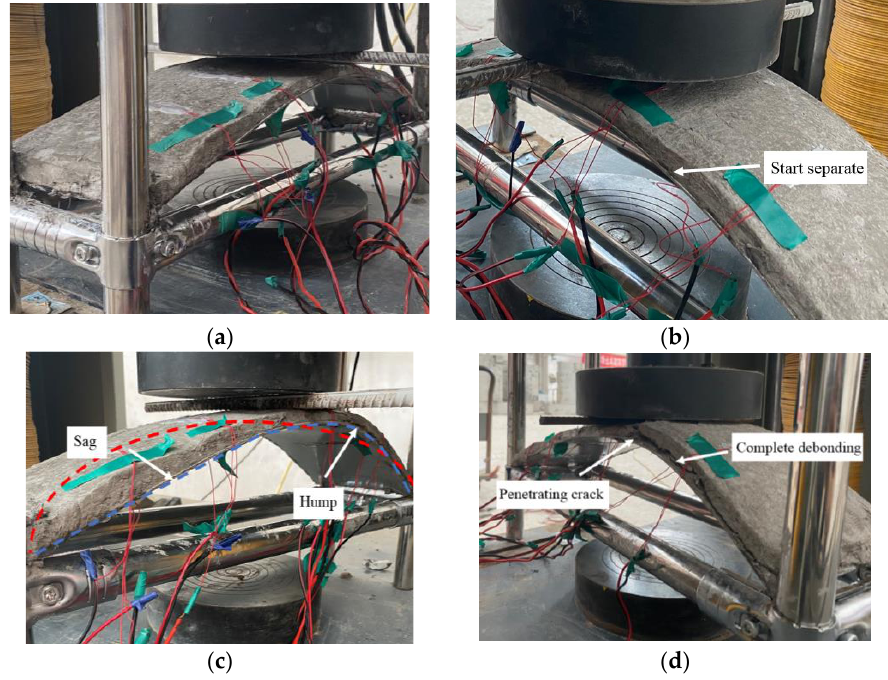
Figure 10. Failure pattern of the 3DPC thin-shell structure: ( a ) Elastic stage; ( b ) Nonlinear stage; ( c ) Separation stage; ( d ) Failure stage.